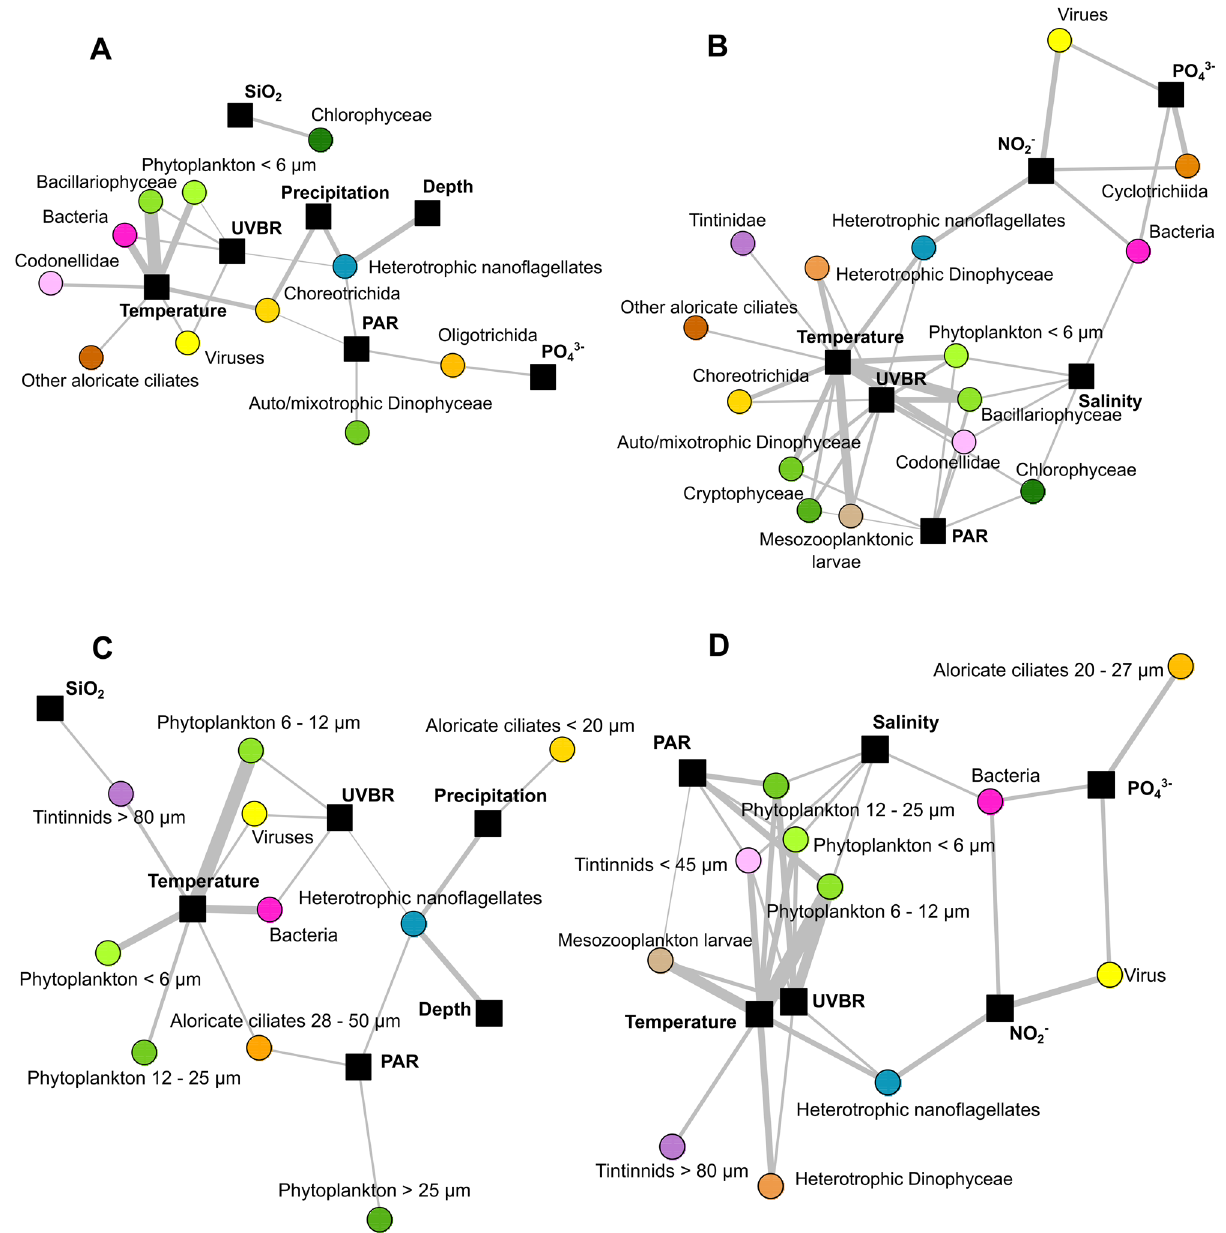
Figure 3. Significant correlations between environmental factors and the abundance of groups obtained considering taxonomy ( A , B ) and ESD classification ( C , D ) in the years 2015 ( A , C ) and 2016 ( B , D ). All correlations were detected by applying Mantel’s test to the most important environmental variables (i.e., those significantly correlated with nMDS axes). Node colours refer to plankton clusters. Black nodes refer to environmental parameters. The edges indicate significant correlations, and their width is proportional to the correlation